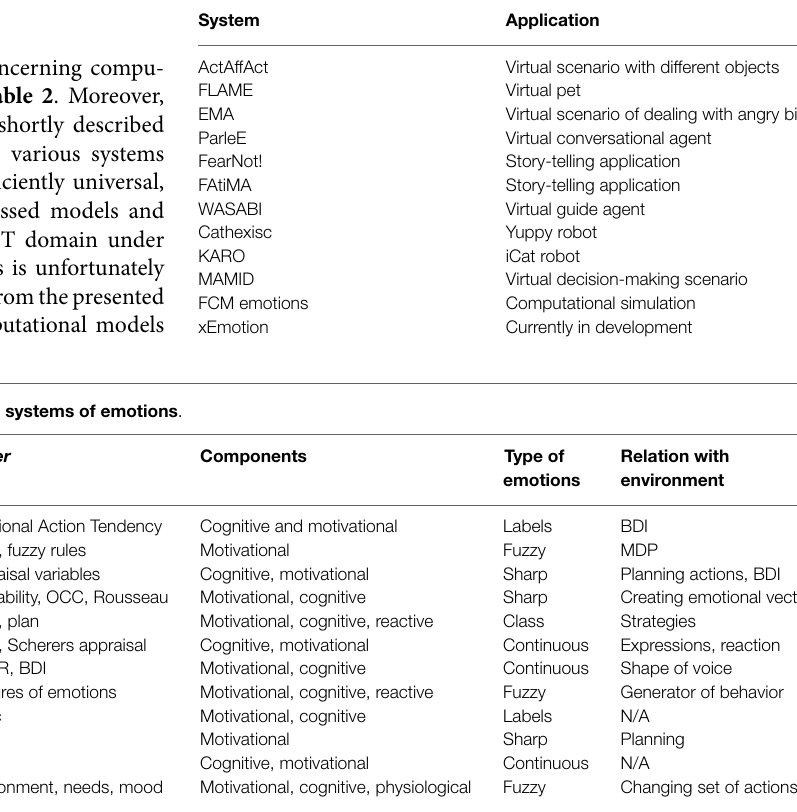
TABLE3 | Applicationsofthe discussedcomputational systems ofemotion .